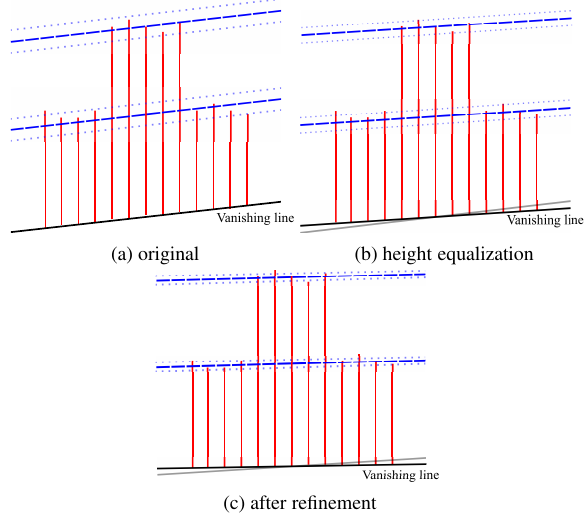
Figure 2: Example of height equalization and refinement of van- ishing